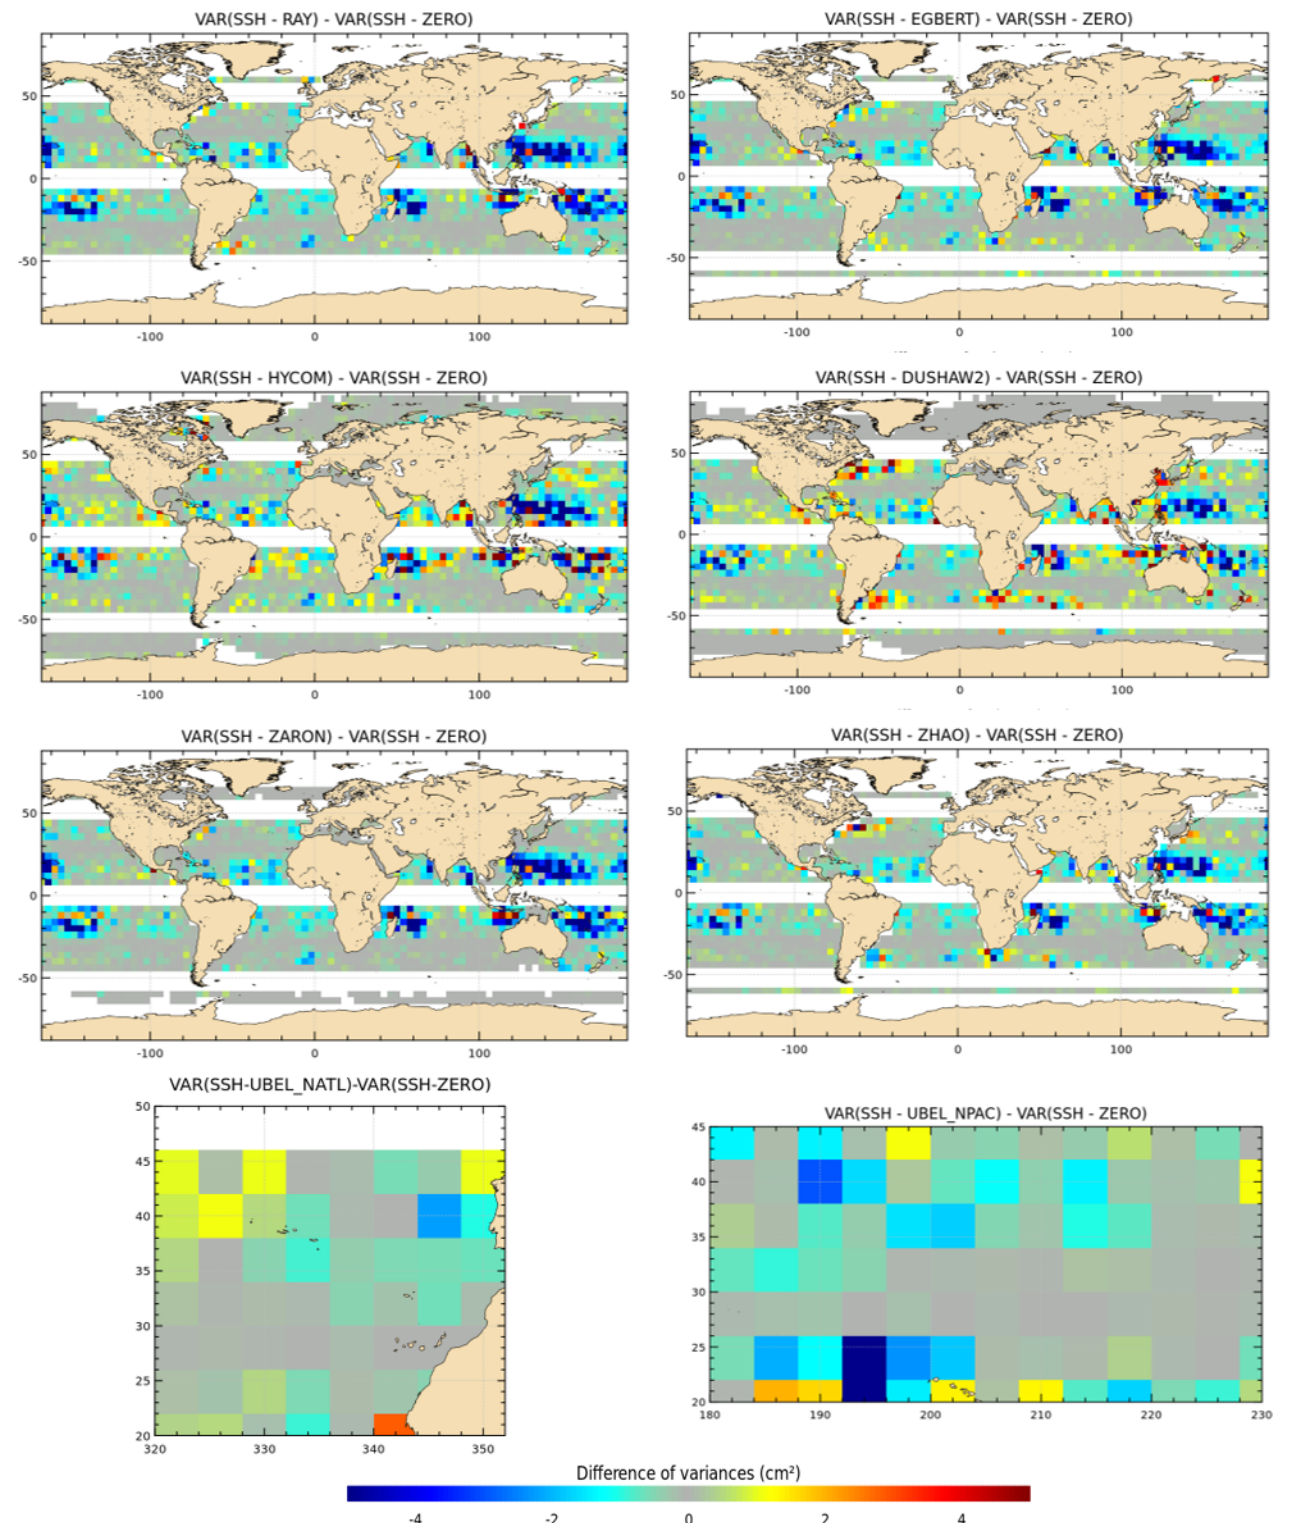
Figure 9. Maps of SSH variance differences at crossovers using either the M 2 IT correction from each model or a ZERO reference correction in the SSH calculation for the C2 mission (cm 2 ). C2 cycles 14–77 have been